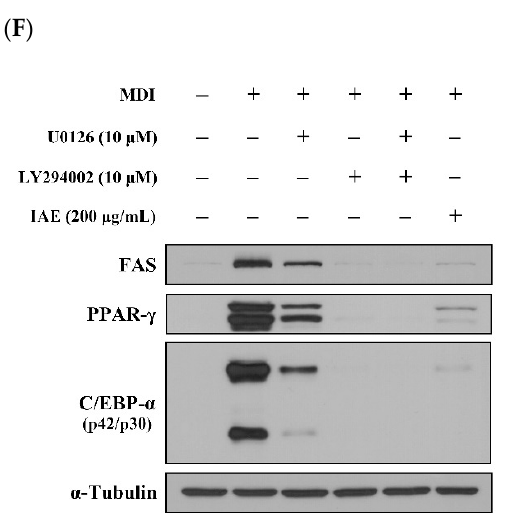
Figure 6. Inula britannica flower aqueous extract (IAE) inhibits the adipogenesis of 3T3-L1 preadipocytes through regulation of the ERK 1 / 2 and Akt signaling pathways. The 3T3-L1 preadipocytes were induced to di ff erentiate by MDI in the presence of indicated concentrations of IAE or specific inhibitors (U0126 and LY294002). Cells were treated with specific inhibitors for 1 h prior to MDI stimulation. The phosphorylation of MEK-1 (Ser217 / 221), ERK 1 / 2 (Thr202 / Tyr204), and Akt (Ser473) was examined to evaluate activation of these proteins. Western blotting was performed to examine the expression levels of proteins. ( A ) Inhibitory e ff ect of IAE on activation of MEK-1 / ERK and Akt during early phase of adipogenesis. ( B ) The dose-dependent inhibitory e ff ect of IAE on MDI-induced MEK / Akt activation was investigated following 30 min of MDI induction. ( C ) Relative protein expression levels of MEK-1, ERK 1 / 2, and Akt. ( D , E ) After 18 h of MDI treatment, the e ff ect of ERK 1 / 2 and Akt signaling pathways on the expression of proteins mediating the cell cycle progression was assessed. ( F ) E ff ect of ERK 1 / 2 and Akt signaling pathways on adipogenesis-associated biomarkers was assessed on day 8. The data are presented as mean ± standard deviation. Values labeled with di ff erent letters (a–e) are significantly di ff erent ( p < 0.05). Di ff erences among the multiple groups were determined based on one-tailed one-way analysis of variance, followed by Tukey’s post hoc test.